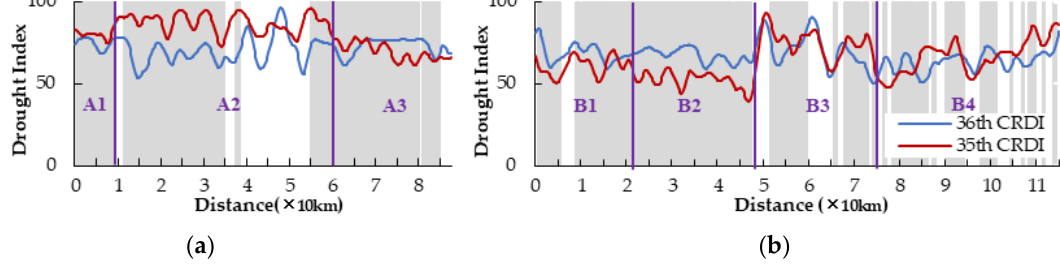
Figure 9. Comparison of CRDI between the 36th and 35th periods of the section line AA’ ( a ) and BB’ ( b ). The grey parts refer to the missing data of the original 36th VCI. According to the trend of the 36th and 35th periods, the CRDI can be divided into several sections separated by purple lines, which were labeled as A1, A2 and A3 and B1, B2, B3 and B4, respectively. The blue line refers to CRDI of the 36th period, and the red line refers to CRDI of the 35th period.